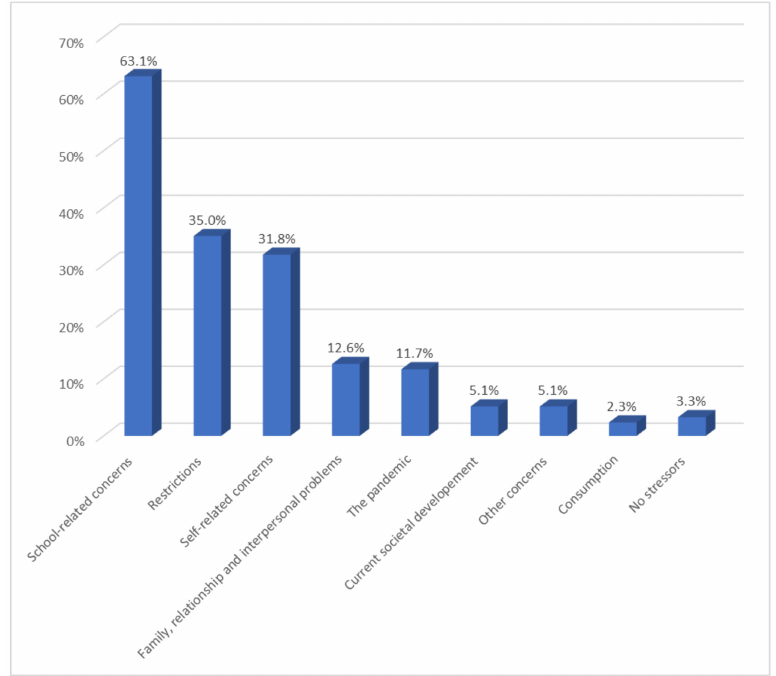
Figure 1. Sources of Greatest Current Concern. The percentages of participants reporting each main category of concerns that emerged from the data for question 1: “What currently gives you the most cause for